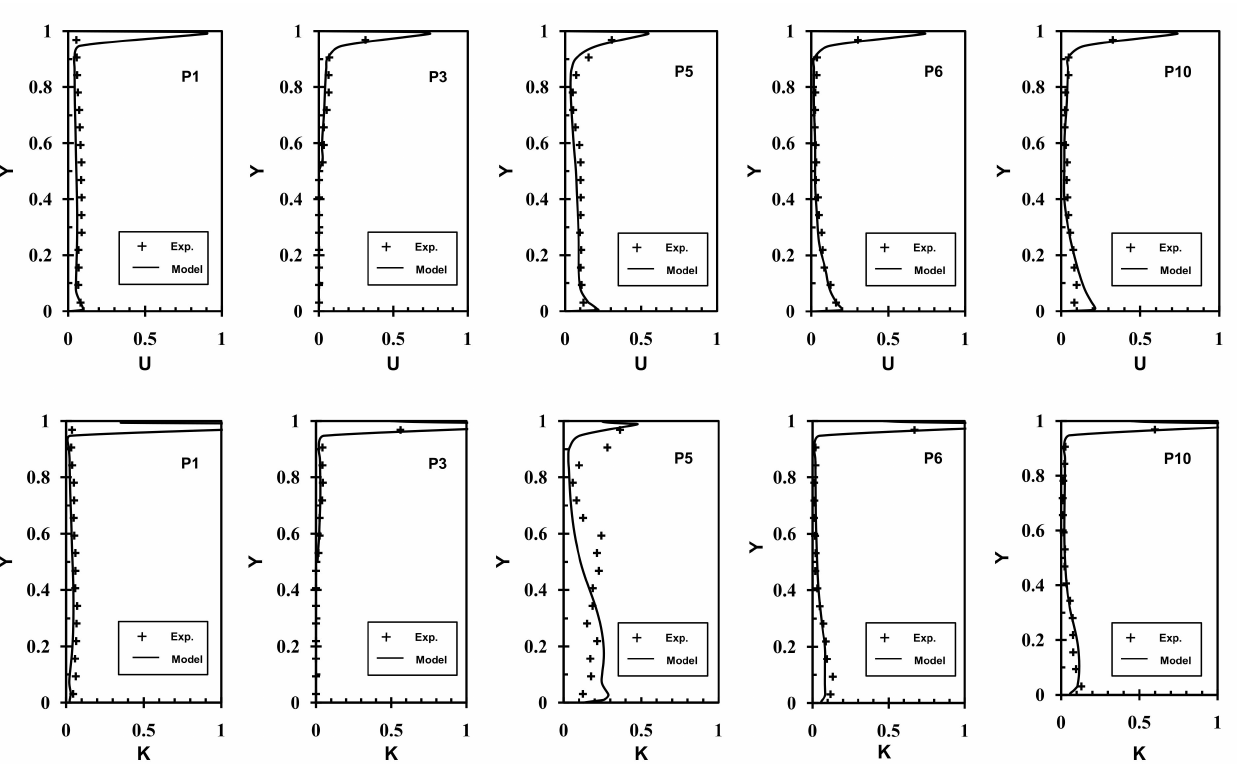
Figure 5. Comparison of normalized velocity and turbulence kinetic energy profiles at monitoring points 1, 3, 5, 6 and 10 for case